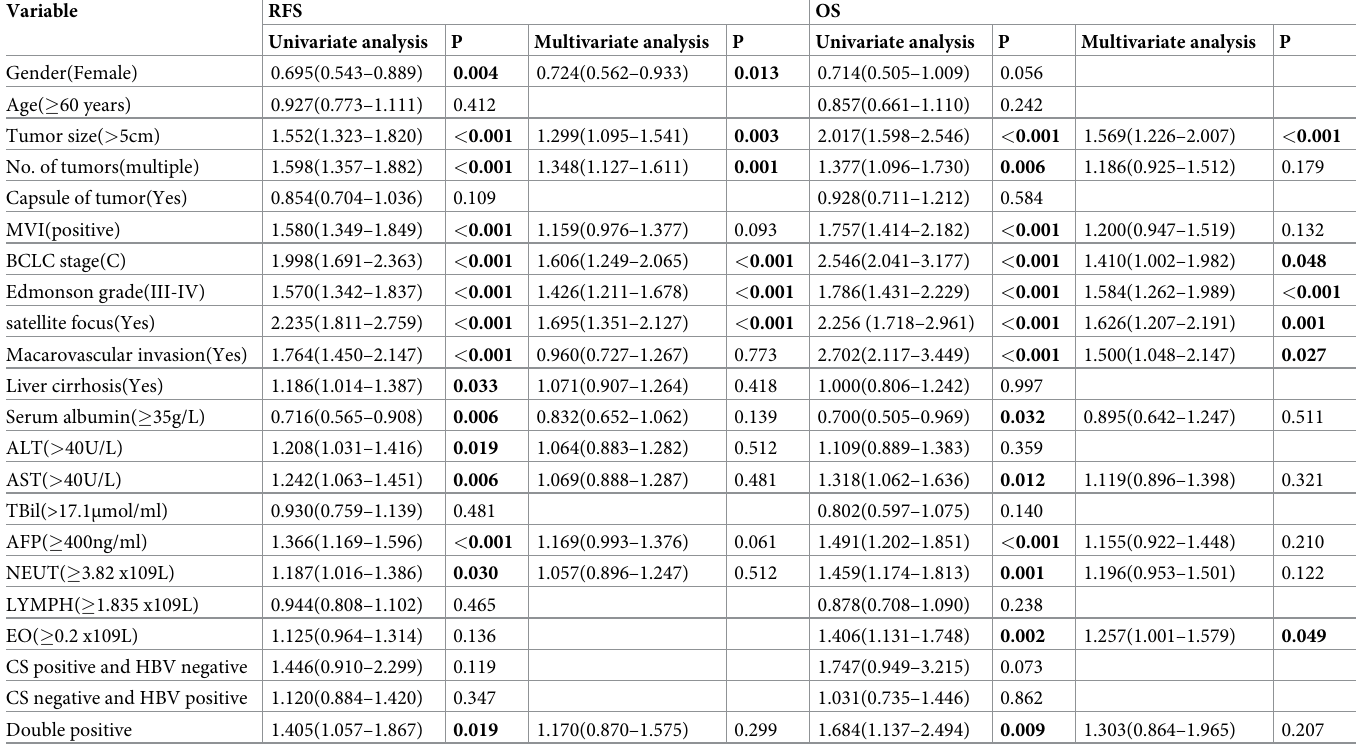
Table 3. Univariate and multivariate analysis of prognostic factors for recurrence-free survival (RFS) and overall survival (OS) among all HCC patients (n =